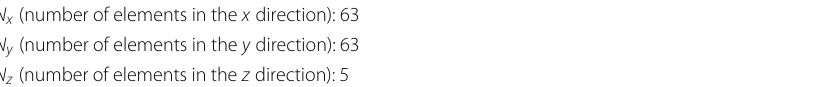
Table 9 Refined FEM mesh considered for computing the reference